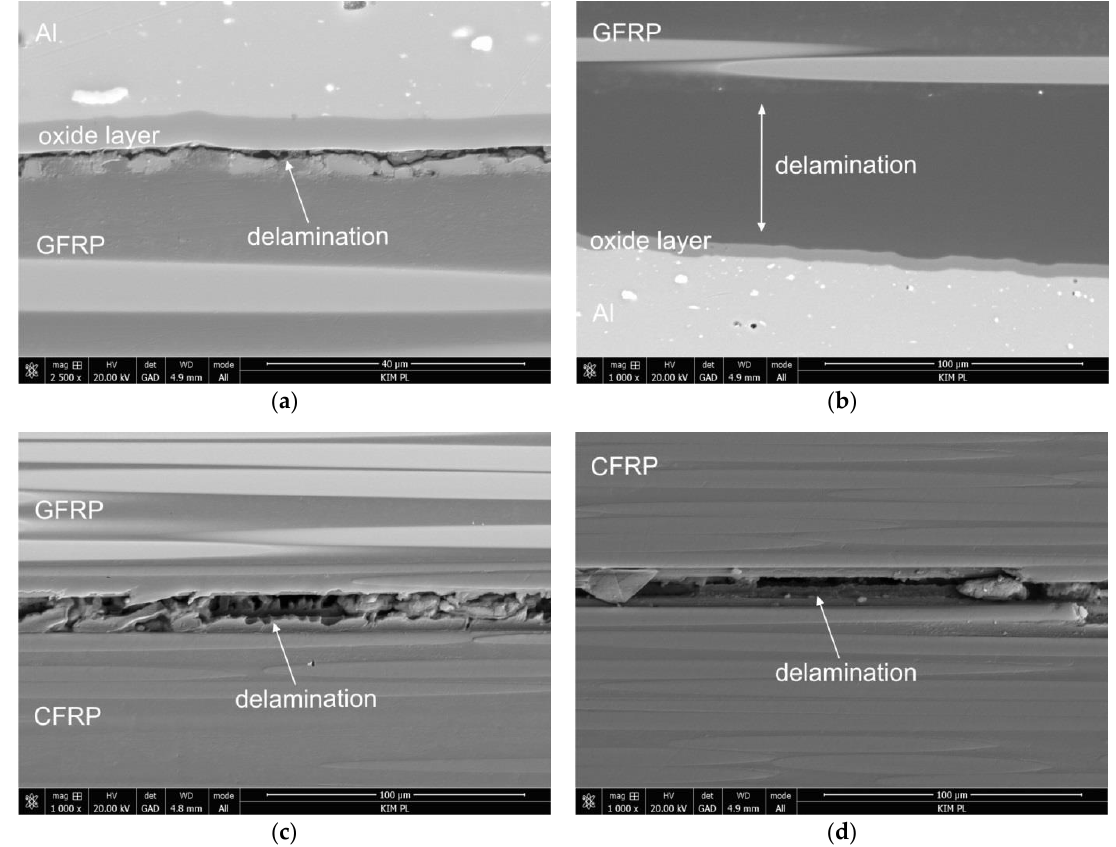
Figure 9. Types of damage in FML laminates with an additional layer of glass composite (FML-GC) before ( a–c ) and after hygrothermal conditioning ( d ).